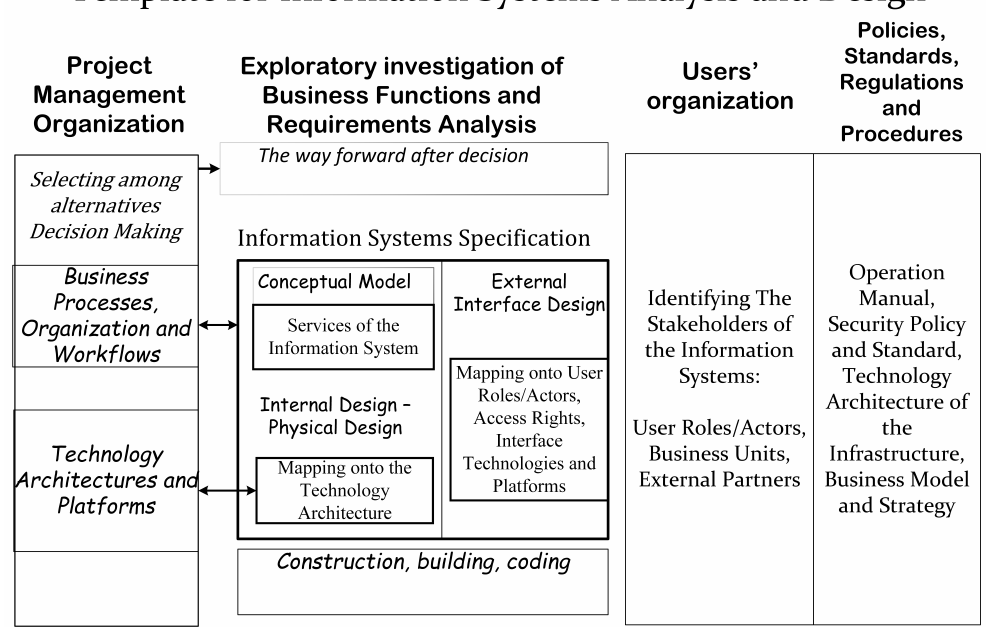
Figure 1. A Conceptual Architecture. Template for Information Systems Analysis and Design. Table 1. Representation of Enterprise Architecture by